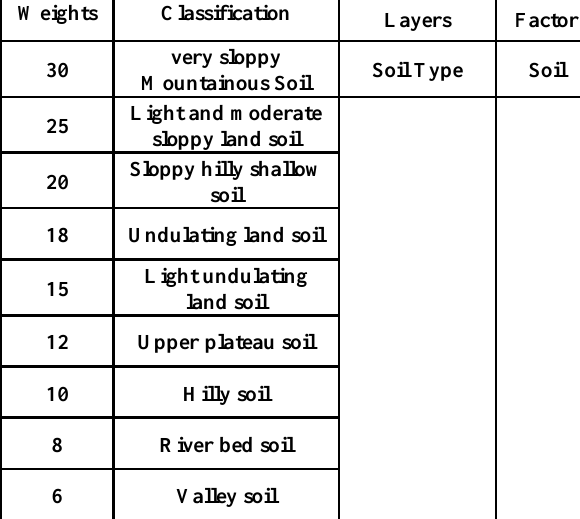
Factor Layers Classification